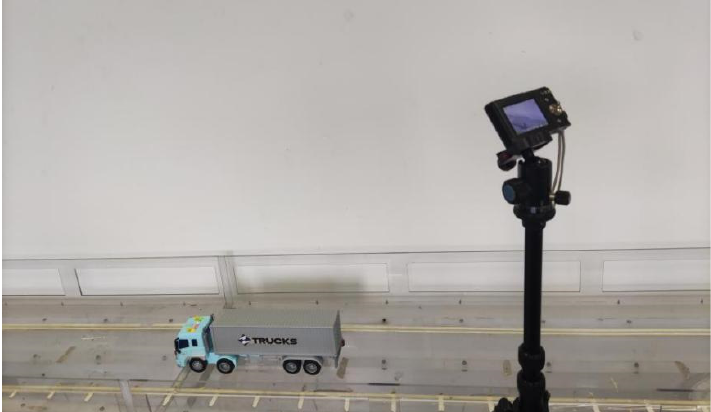
Figure 9. Layout of the model truck and camera.